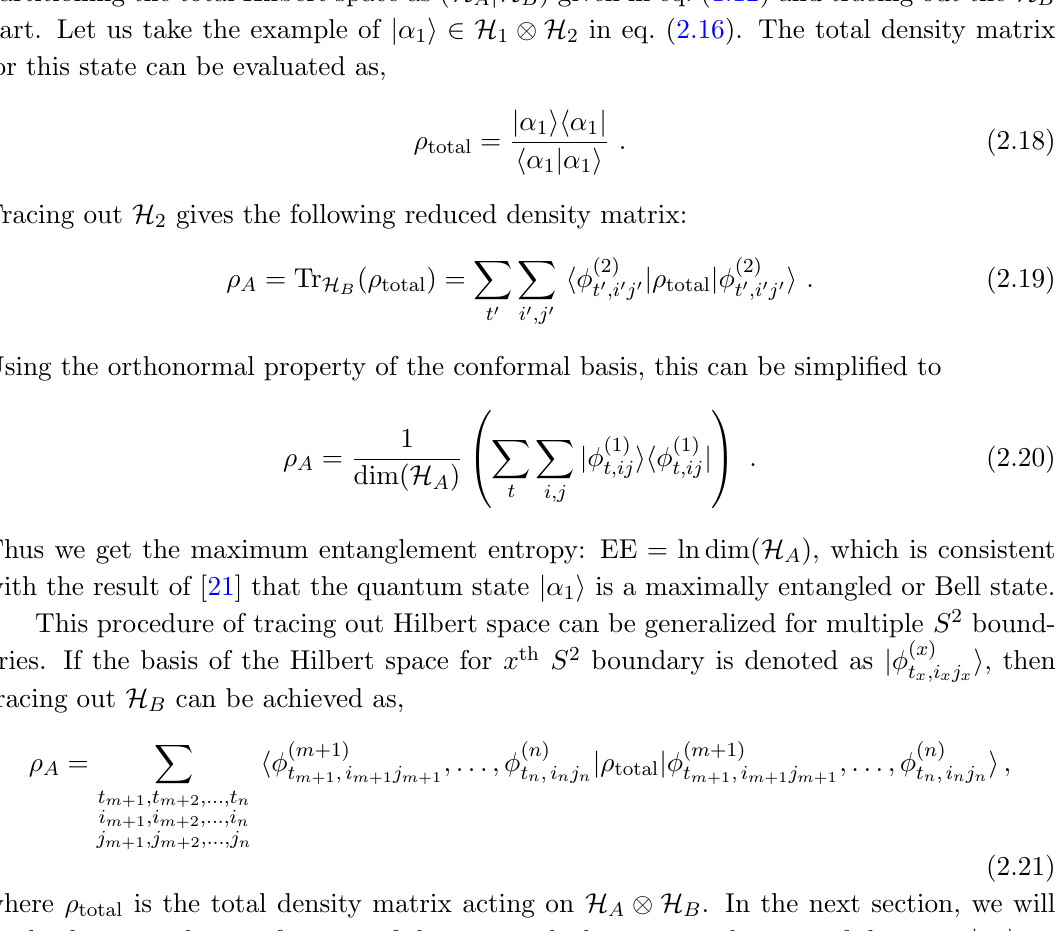
Figure 6 . An example showing how the quantum state on S 2 the state on multiple S 2 boundaries and gluing the extra S 2 ’s with the appropriate oppositely oriented boundaries of other quantum